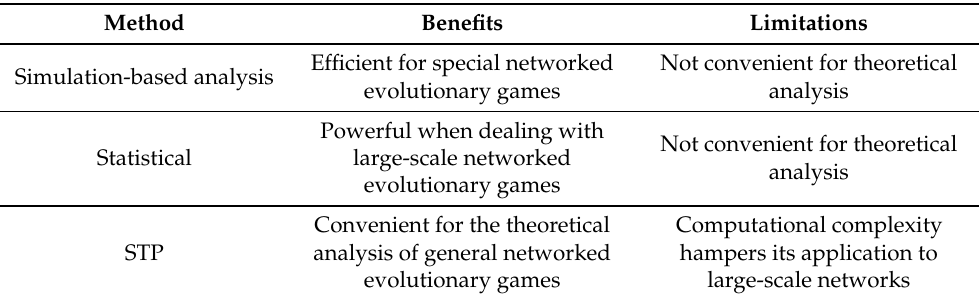
Table 4. Comparative analysis of various methods for networked evolutionary